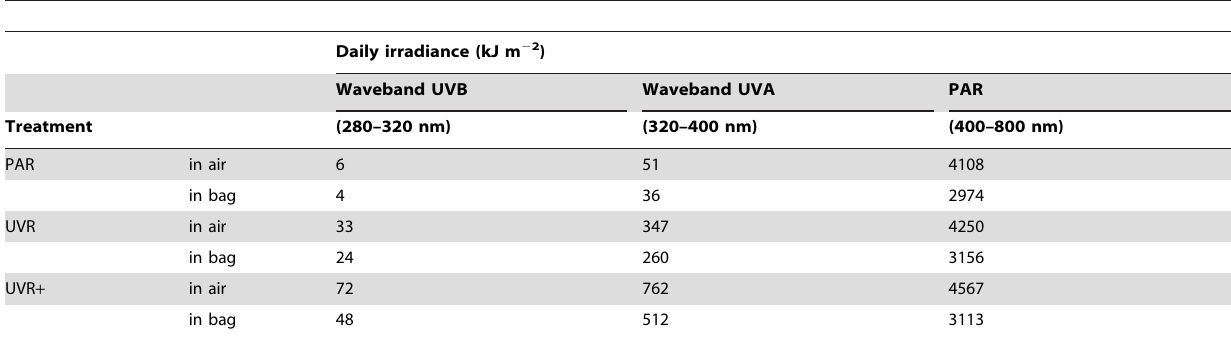
Table 1. Daily irradiance of UVB, UVA and PAR provided to Thalassiosira weissflogii cultures used as food for Calanus finmarchicus .